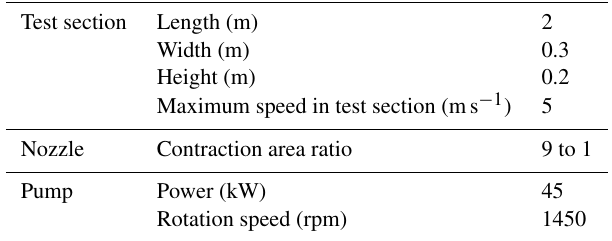
Table 1. General specifications of the free surface water tunnel and the test section (Seyyedi and Shafaghat,